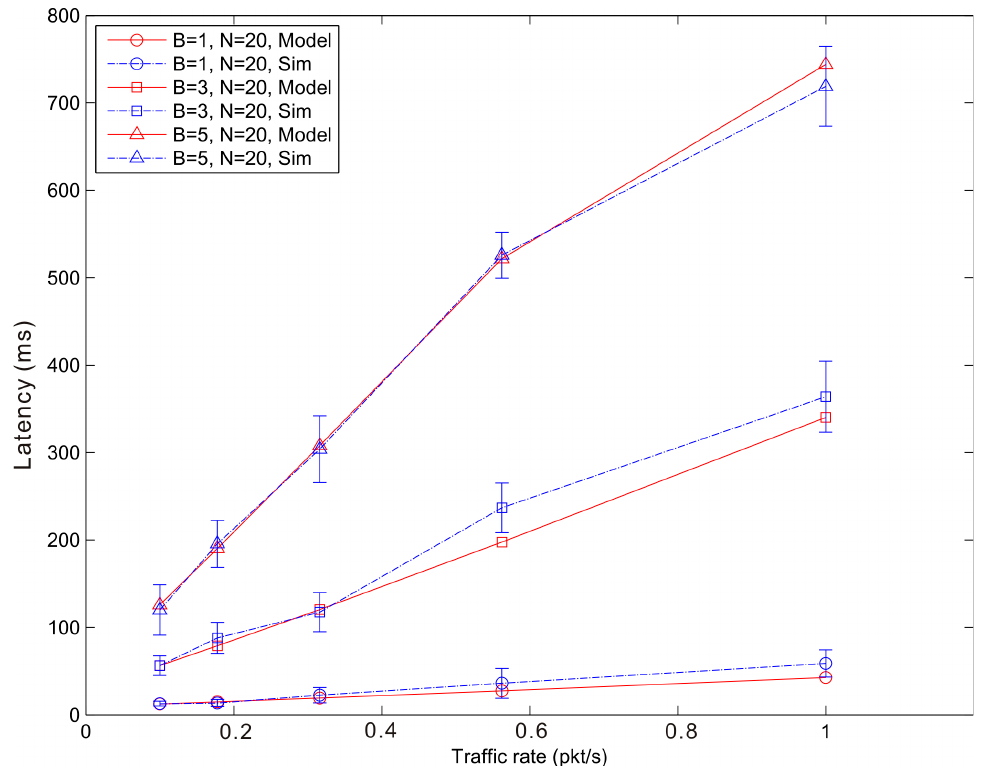
Figure 16. Blockwise Latency versus traffic rate for a star topology network composed by 20 nodes.